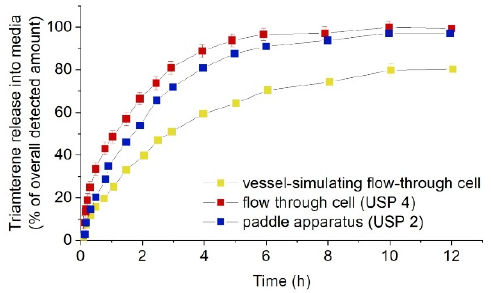
Figure 11. Schematic overview of the in vitro test setup ( A ) and photograph of the vFTC equipped with a 2 wt% agarose gel ( B ); (1) vFTC, (2) media container, (3) PBS of pH 7.4, (4) paddle stirred at 50 rpm, (5) peristaltic pump, (6) heated water bath, (a) glass beads, (b) stainless steel disc, (c) hydrogel, reproduced with permission from [59].